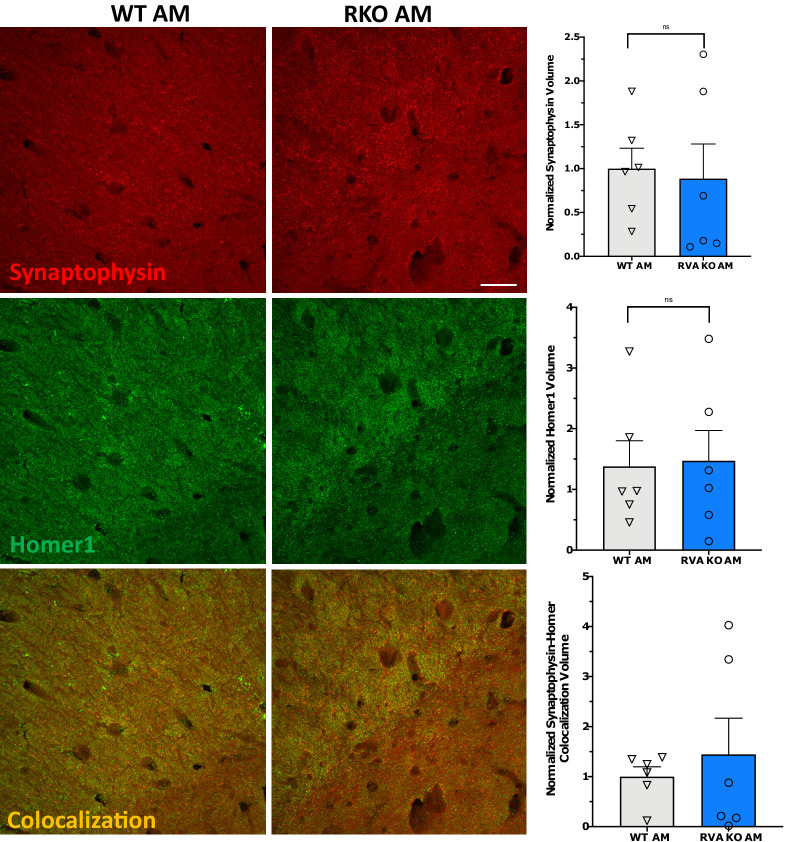
REV-ERBα deletion does not induce synapse loss in CA1.Representative 60X maximum intensity projects of synaptophysin and homer1 staining in the CA1 region of WT or RKO mice as well as the associated normalized volume quantifications (N = 5/group).